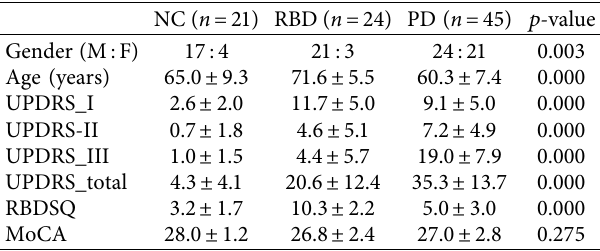
Table 1: Demographic and clinical characteristics of all